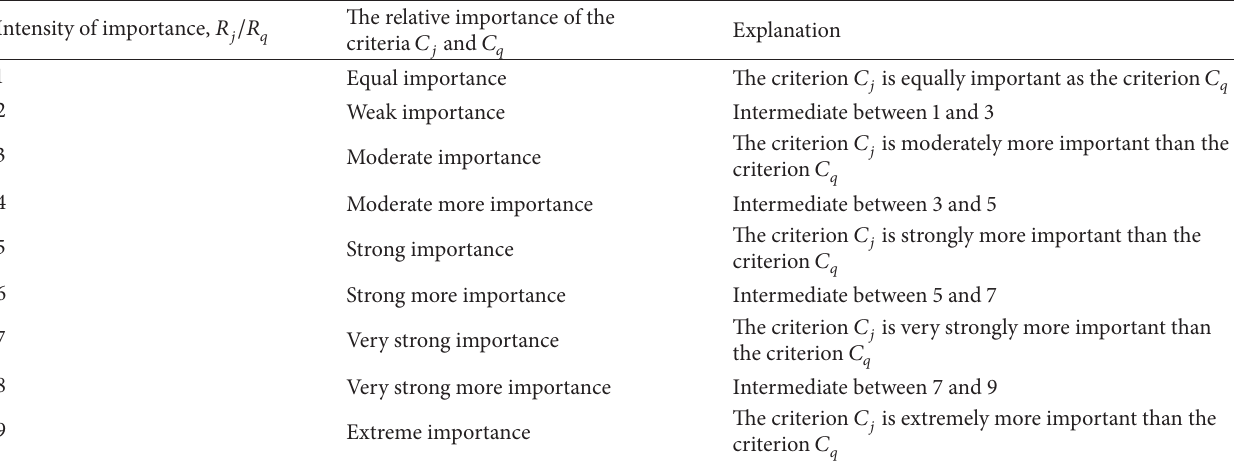
Table 1: Scale of the relative importance of